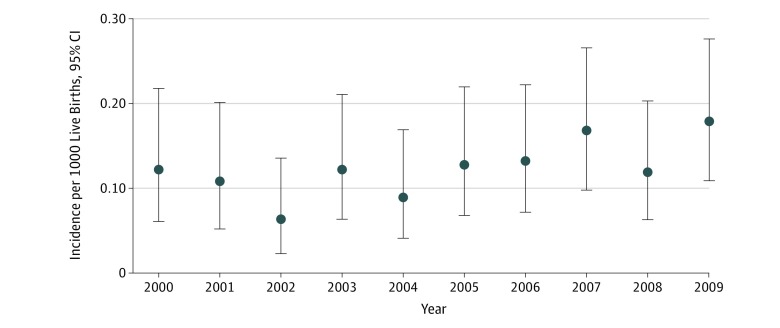
Yearly Incidence (95% CI) of Late-Diagnosed Hip Dislocation in SwedenError bars indicate 95% CIs.